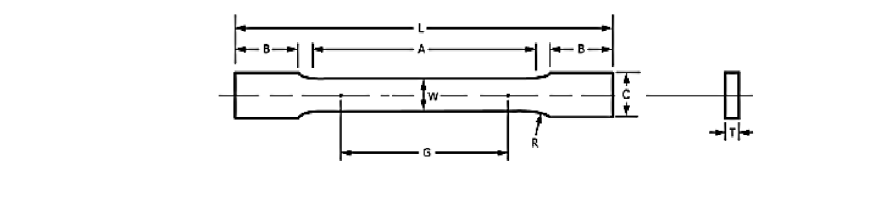
Figure 1. ASTM B557M standard tensile bar.